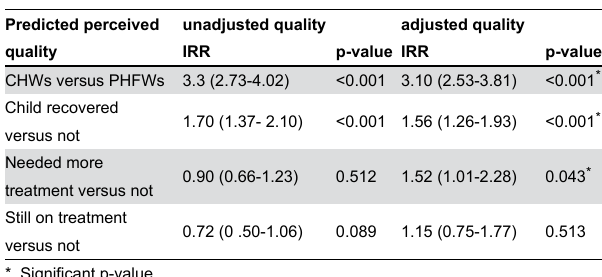
Table 7. Modified Poisson regression models for the association the between the predicted quality score and both service providers and visit outcomes (N=